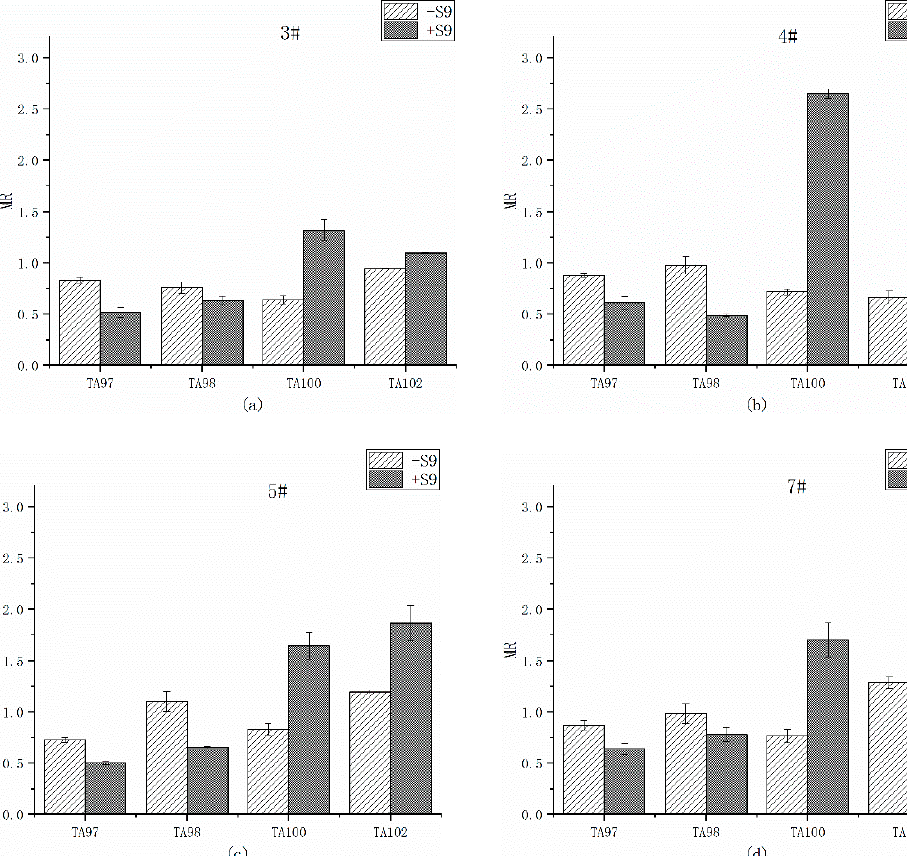
Figure 3. Mutagenesis of four strains by overlying water in the presence and absence of liver microsomal S9; ( a ) site 3#; ( b ) site 4#; ( c ) site 5#; ( d ) site 7#. The mutagenicity ratio (MR) is the average ratio from 3 independent experiments.